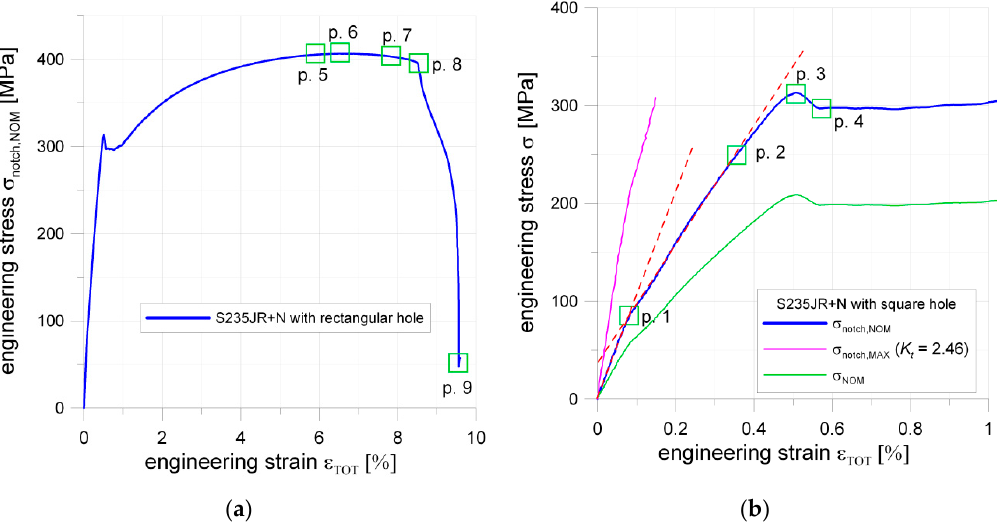
Figure 12. Tensile behavior of S235JR + N: ( a ) engineering σ – ε curve for plate with square hole with corner fillet radius; and ( b ) magnified initial part of the curve.